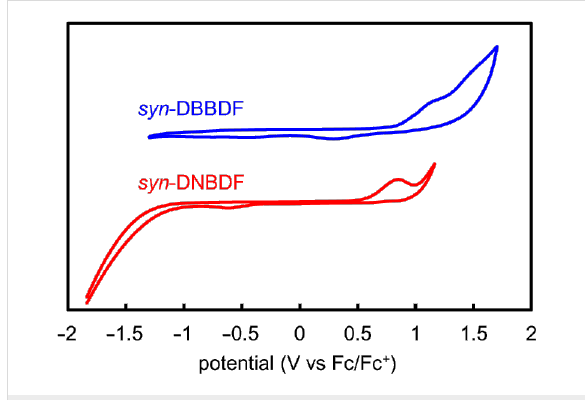
Figure 4: Cyclic voltammograms of syn -DBBDF 5 and syn -DNBDF 6 (measurement conditions: 1.0 mM in CH 2 Cl 2 for syn -DBBDF 5 or Cl 2 CHCHCl 2 for syn -DNBDF 6 with 0.1 M Bu 4 NClO 4 ; Pt as working and counter electrodes; scan rate = 50 mV·s − 1 ). Fabrication of OFETs with syn -DBBDF-